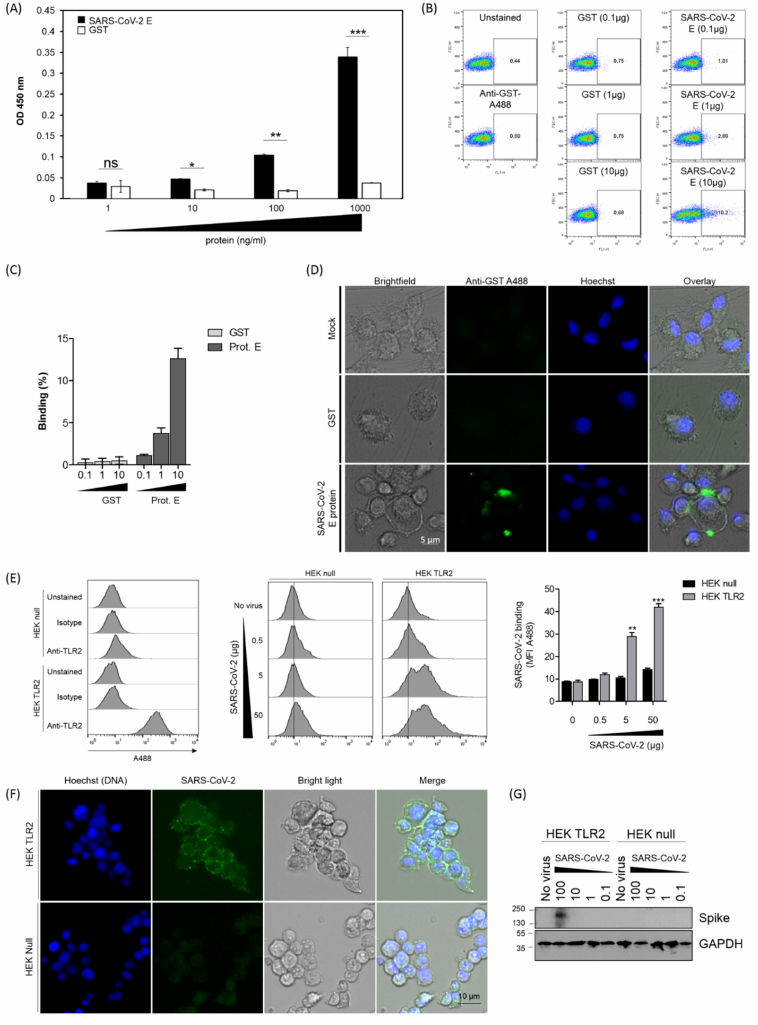
Figure 1. Binding of SARS-CoV-2 protein to human TLR2 . ( A ) Soluble recombinant human TLR2 (100 µ L at 1 µ g/mL) was coated in 96-well plates. After saturation, various amounts of the E-GST protein (1 ng/mL–1000 ng/mL) were added for 2 h at 37 ◦ C. TLR2 E-GST complexes were revealed